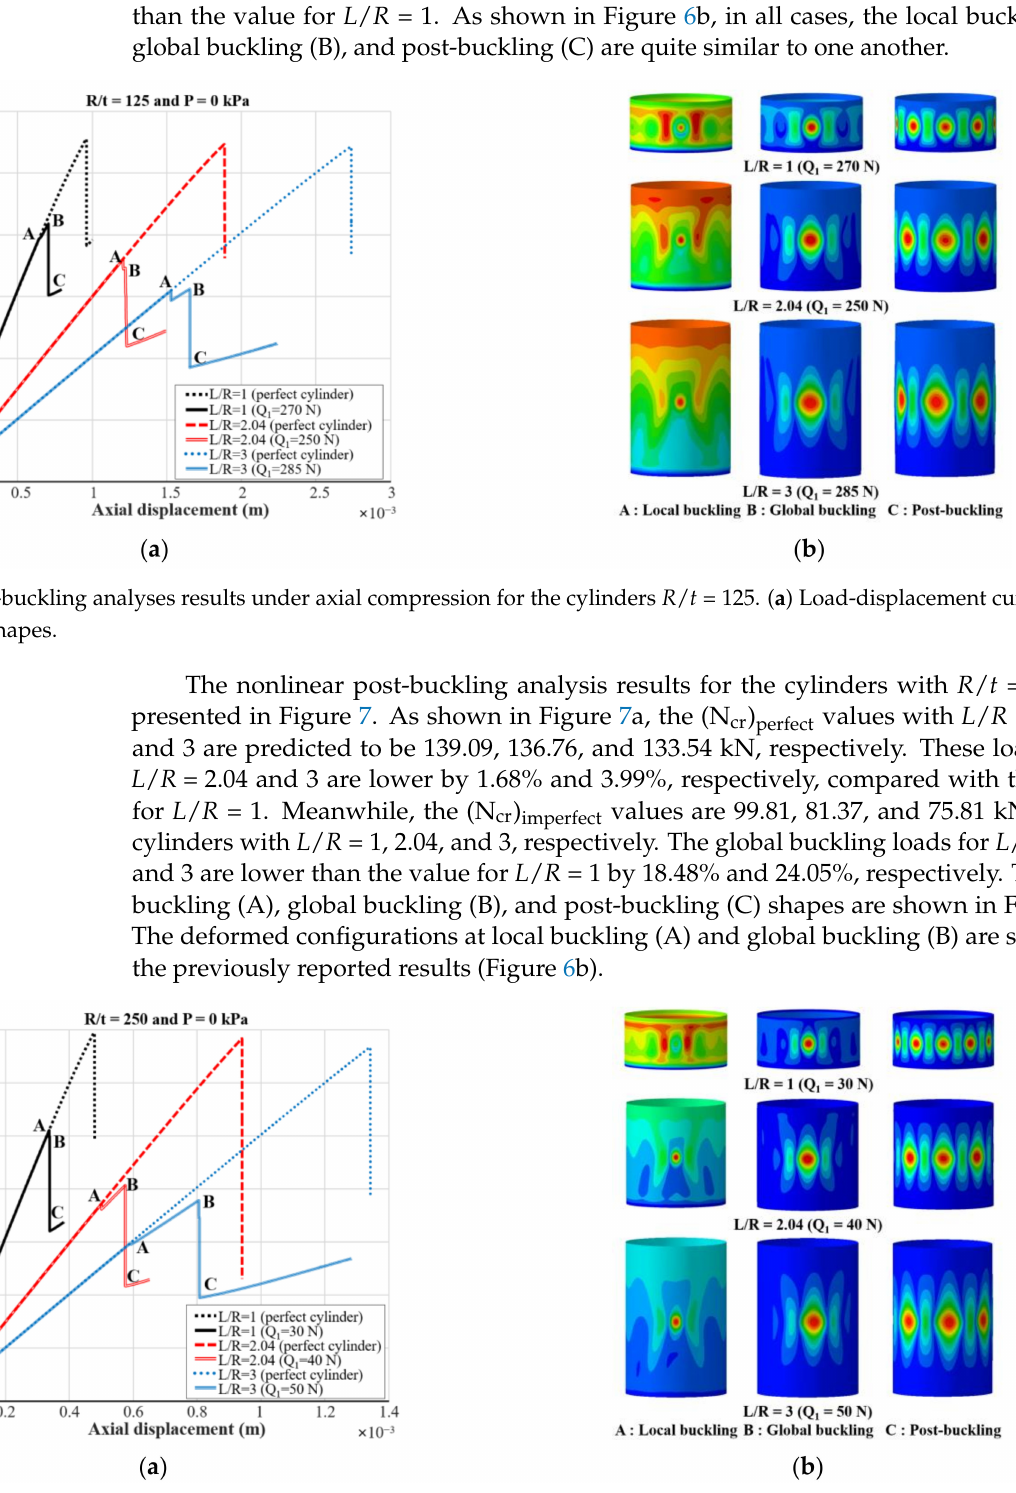
Figure 7. Post-buckling analyses results under axial compression for the cylinders R / t = 250. ( a ) Load-displacement curves, ( b ) Buckling